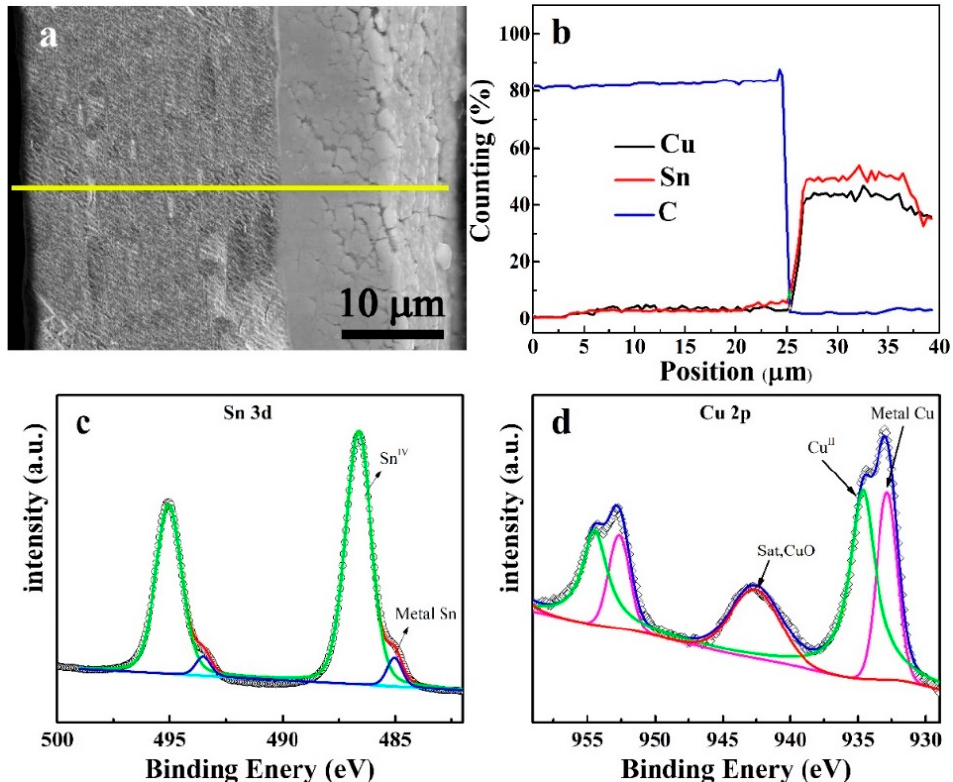
Figure 3. Cross-section image ( a ) and the linear scan of the EDS result ( b ) of the Cel-CS electrode. The high-resolution XPS survey of Sn 3d ( c ) and Cu 2p ( d ).